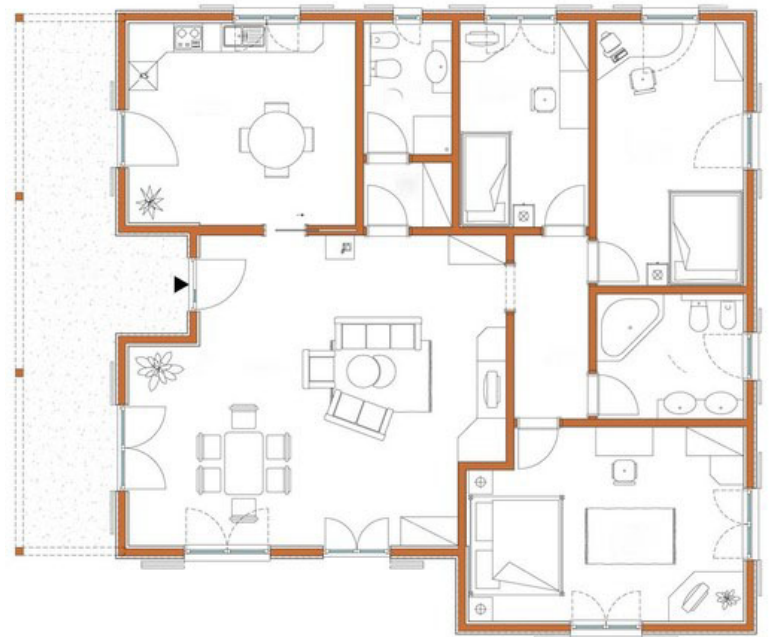
Figure 2. Example of planimetry that can be imported in the tool for the automatic creation of the 3D